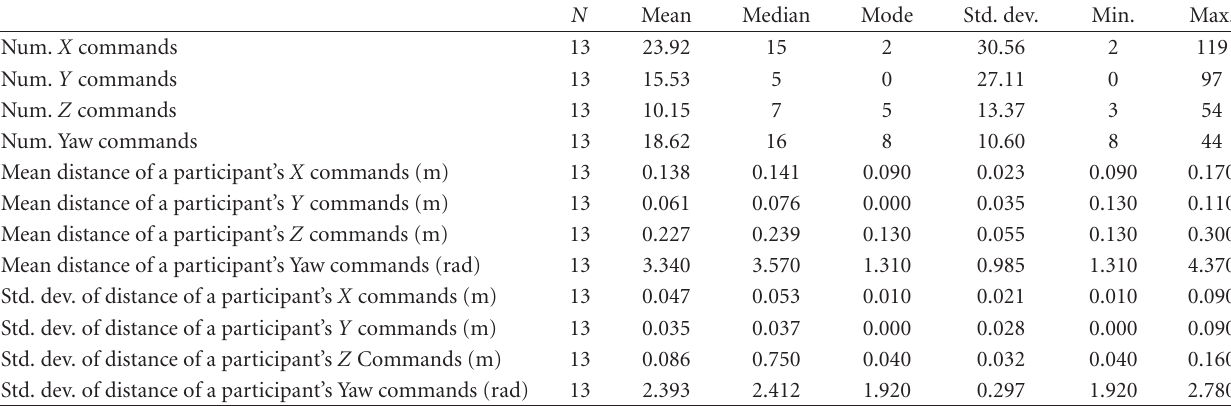
Table 3: Descriptive statistics of nudge control commands performed by participants during the scored